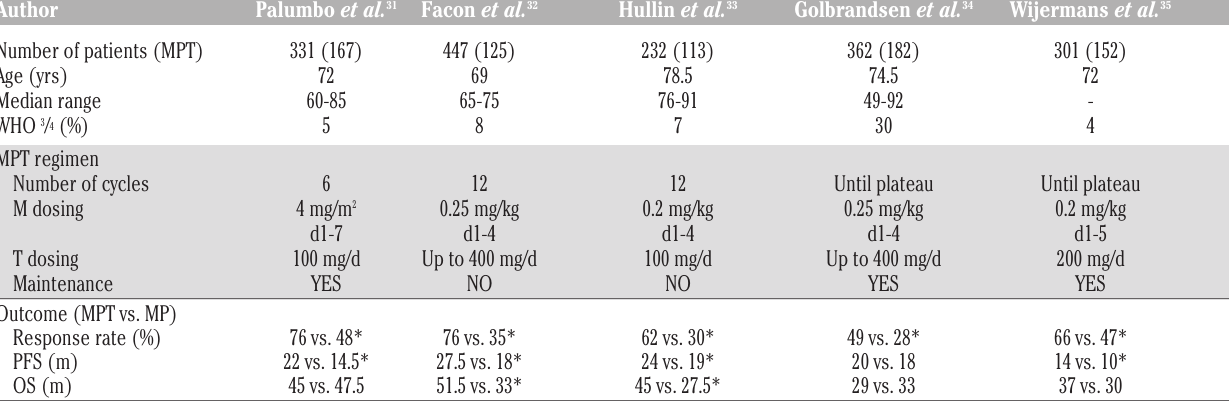
Table 3. Melphalan-prednisone versus melphalan-prednisone-thalidomide studies: absence of impact of maintenance with thalidomide on overall